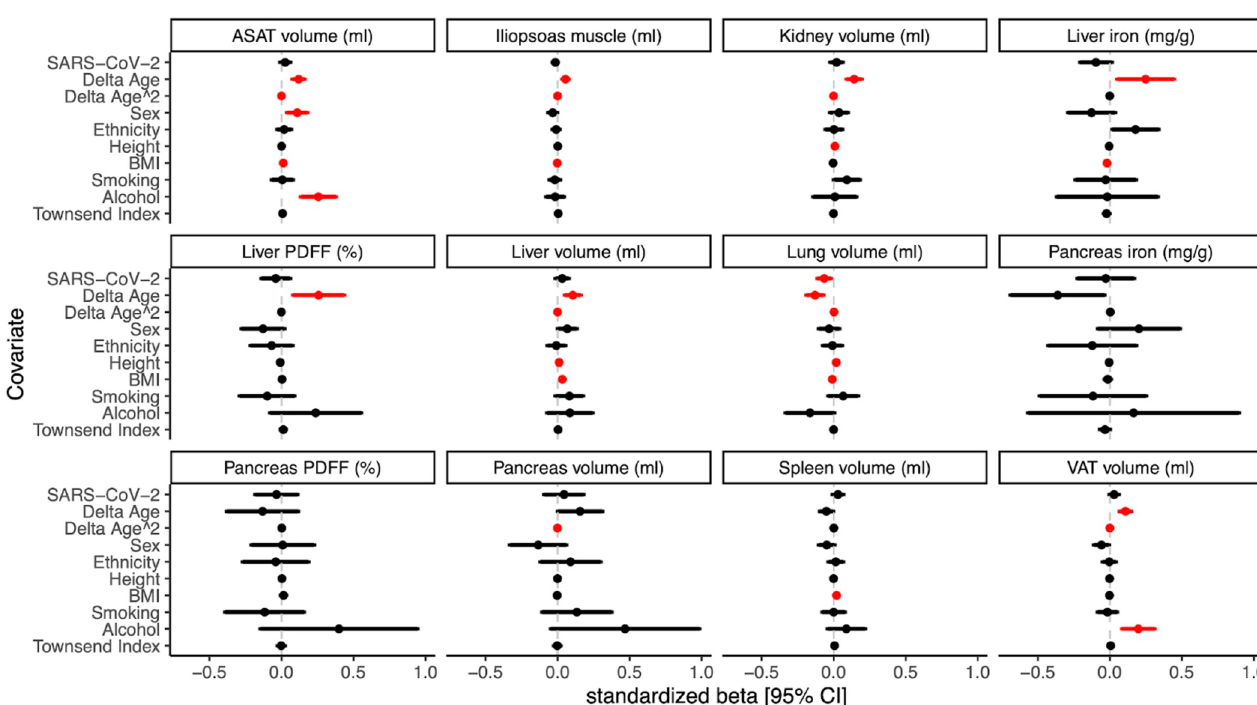
Fig 2. Changes in abdominal image-derived phenotypes are associated with age, sex, BMI, and SARS-CoV-2 test positivity. There were 967 positive cases and 913 matched negative controls for a total sample size of 1,880. Multiple linear regression modeling was performed (Methods). 95% confidence intervals around standardized betas are shown. Significant associations (FDR � 0.05) are shown in